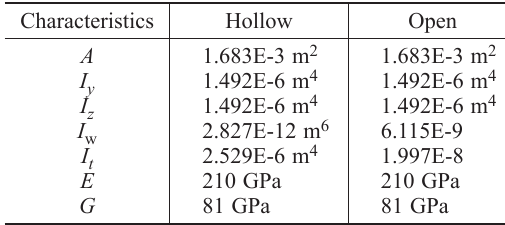
Table 1. Cross-section characteristics Characteristics Hollow Open A I y